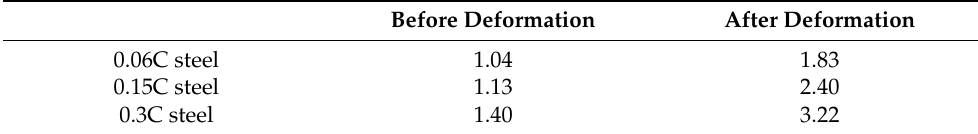
Table 2. Dislocation density of ferrite (10 14 , m − 2 ) in 0.06C steel, 0.15C steel, and 0.3C steel. Before Deformation After